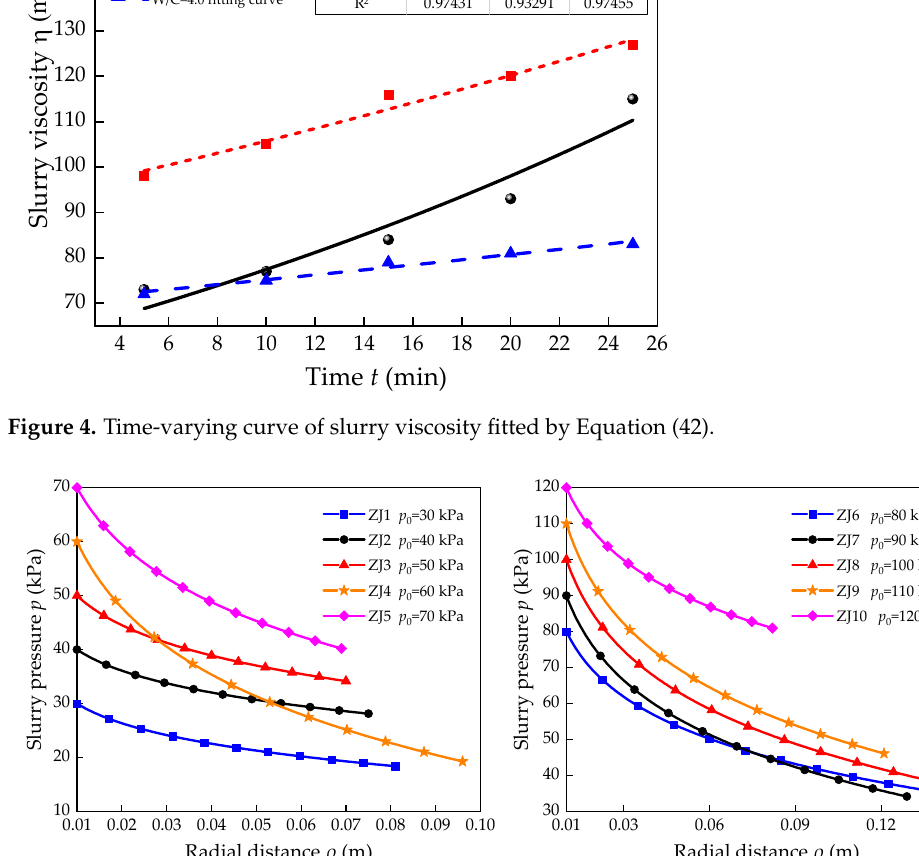
W/C=3.0 measured value W/C=3.0 fitting curve W/C=3.5 measured value W/C=3.5 fitting curve W/C=4.0 measured value W/C=4.0 fitting curve